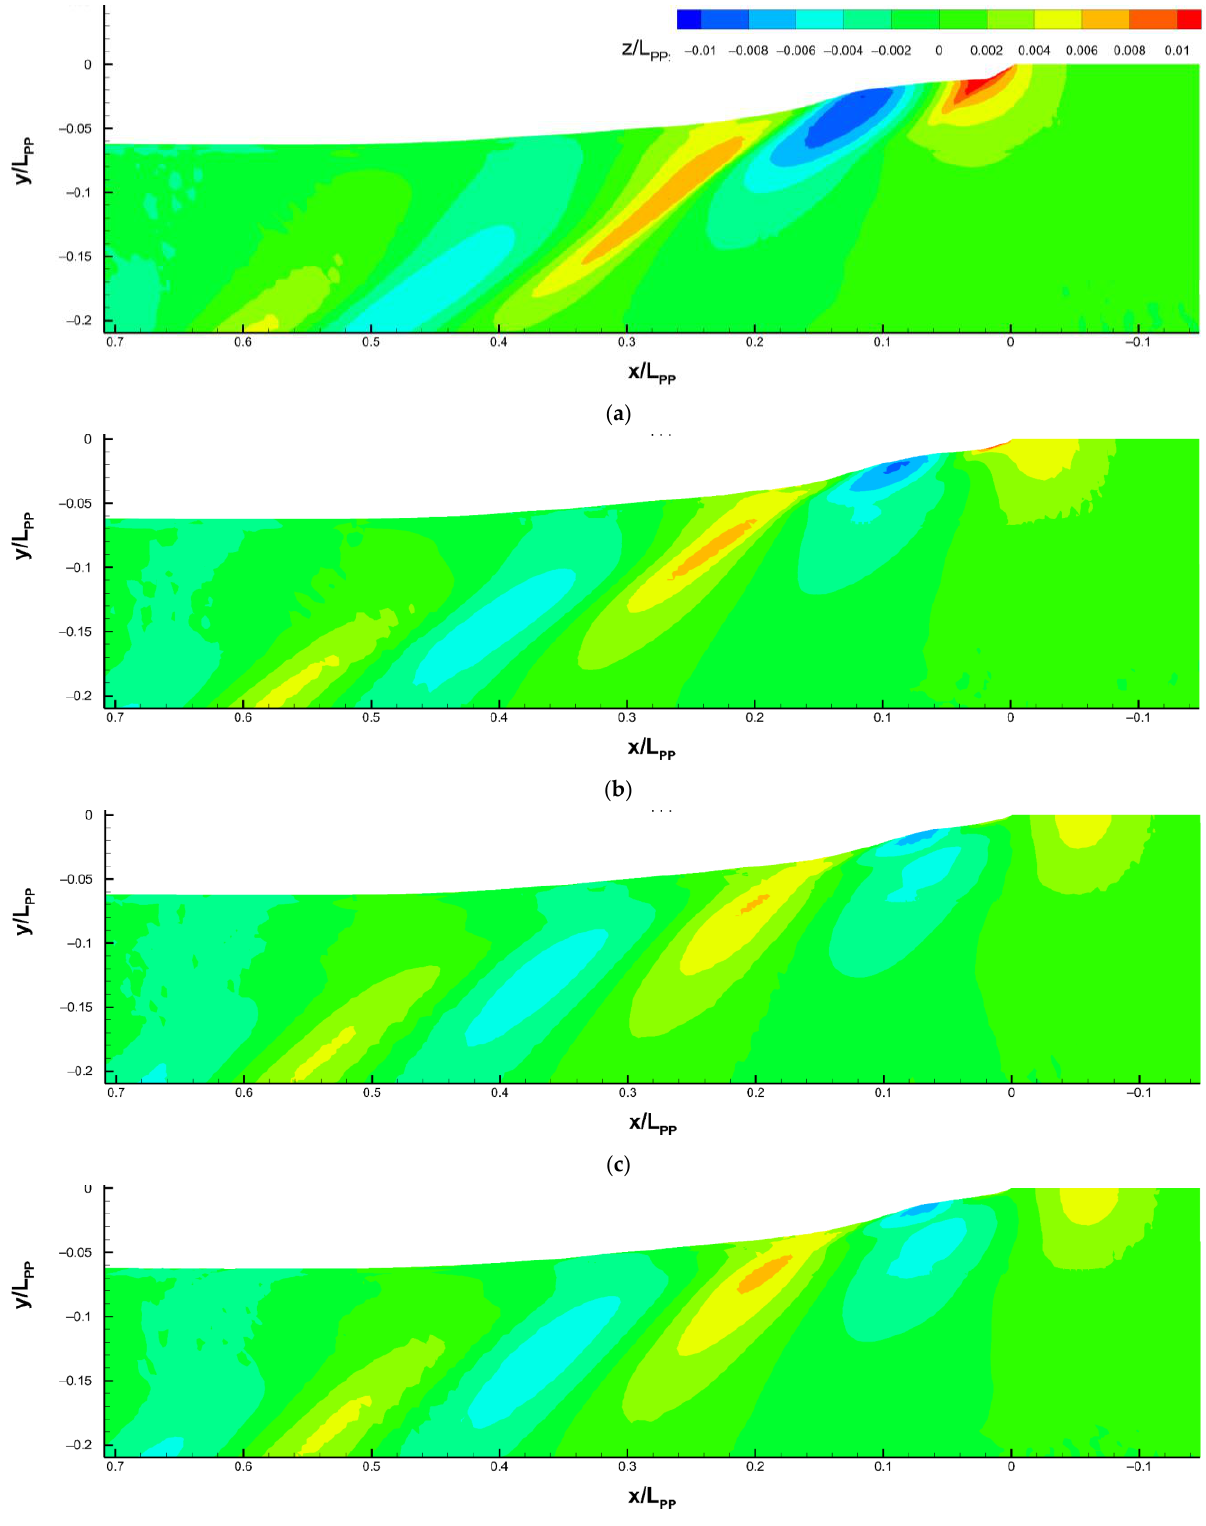
Figure 9. Bow wave elevation: ( a ) F0; ( b ) F0.14; ( c ) F0.225; ( d ) F0.24. By overlapping the waves of each dome design and F0, Figure 10 reveals the stern waves are almost identical. Moreover, the bow and stern wave envelopes of both sonar domes and their angles are consistent. The difference is the phase of the bow waves, which